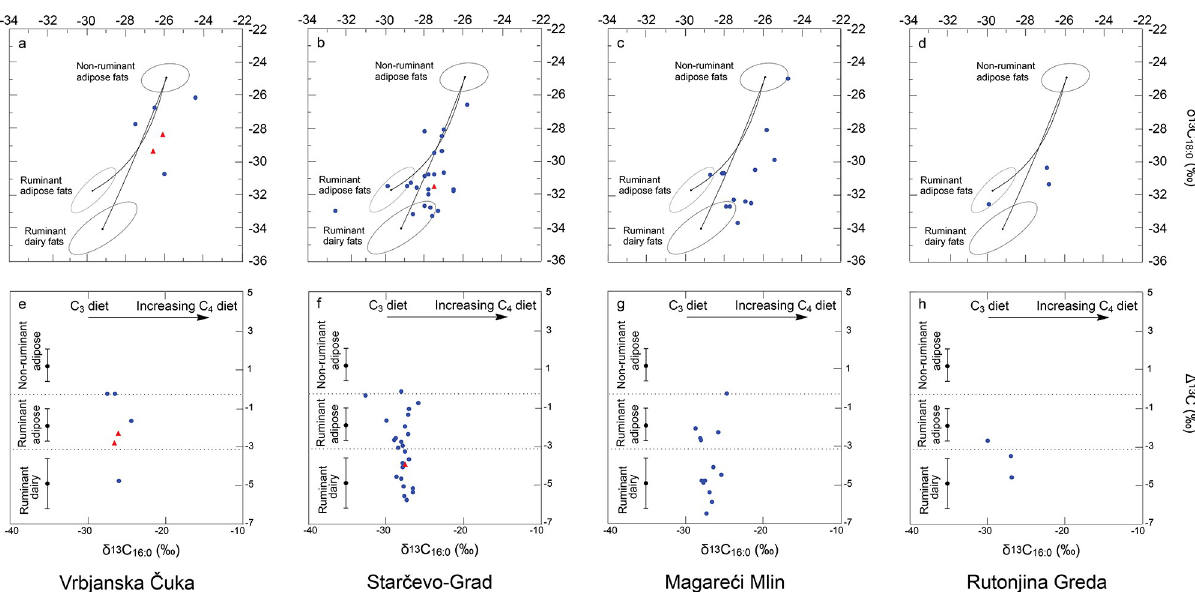
Fig 3. Graphs showing: a, b, c, d , δ 13 C values for the C 16:0 and C 18:0 fatty acids for archaeological fats extracted from Vrbjanska Č uka, Star č evo-Grad, Magare ć i Mlin and Rutonjina Greda vessels, respectively. The three fields correspond to the P = 0.684 confidence ellipses for animals raised on a strict C 3 diet in Britain [41]. Each data point represents either: blue circle—terrestrial animal product; red triangle—plant/animal product mixture; Plots e, f, g, h , show the Δ 13 C ( δ 13 C18:0 – δ 13 C 16:0 ) values from the same potsherds. The ranges shown here represent the mean ± 1 s.d. of the Δ 13 C values for a global database comprising modern reference animal fats from Africa [42], UK (animals raised on a pure C 3 diet) [36] Kazakhstan [43], Switzerland [44] and the Near East [45], published elsewhere.